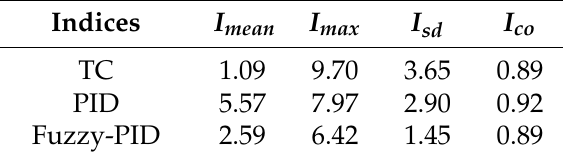
Table 3. Indices for the first set of experiments.